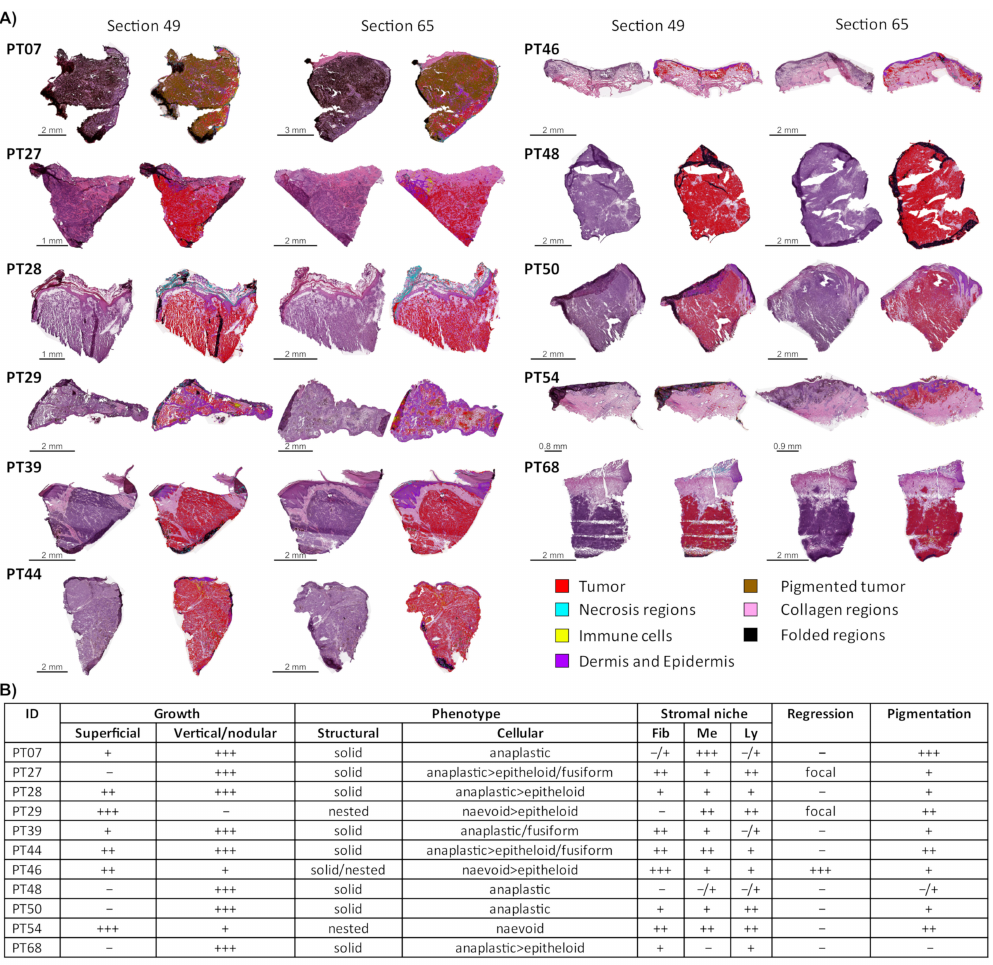
Figure 2. Histopathological characterization of the cohort of primary melanomas. ( A ) Tissue sections before and after the scanner (Leica Biosystems, San Diego, CA, USA), and the digital images were submitted to histopathological characterization of the tissue composition. Histological images were analyzed under the QuPath platform using a cell-based profiling mode. Each section is presented as a H&E scanned image (left) and an annotated image as the output of the analysis platform (right). The summary of the histological characterization is outlined in Table S1. All images are arranged as top-down (from skin surfaces to inside of skin). ( B ) Representation of the histopathological characterization of the examined primary melanoma samples according to standardized dataset involving the growth, structural and cellular phenotypes, stromal niche variables (Fib: fibrotic/desmoplastic reaction; Me: melanophages; Ly: lymphocytic infiltration), regression, as well as pigmentation. For the extension of the horizontal spreading of the melanoma ‘+’ indicates focal superficial spreading counterpart which limited less than 25% of the total horizontal extension of the examined tumor sample without the dominancy of the superficial spreading component. The ‘++’ indicates well recognizable superficial counterpart occupying >25% of the total horizontal extension; however, with a dominant vertical spreading/regressive area. The ‘+++’ indicates a marked and dominant superficial spreading component >75% of the total horizontal extension of the examined tumor sample. Indeed ‘+++’ in the regression column indicates a dominant diffuse (>75%) regressive component within the tumor sample (PT46). Similarly, intratumoral pigmentation was semiquantitatively counted by ‘+++’ diffuse and marked pigmentation, ‘++’ scattered focal, but pronounced pigment accumulation, ‘+’ focal and moderate intratumoral pigmentation, ‘ − /+’ focal mild pigmentation within the tumor